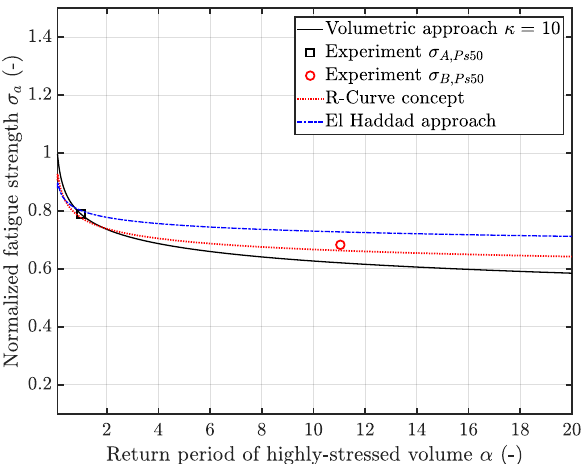
Figure 16. Validation of the fatigue assessment model considering the statistical size